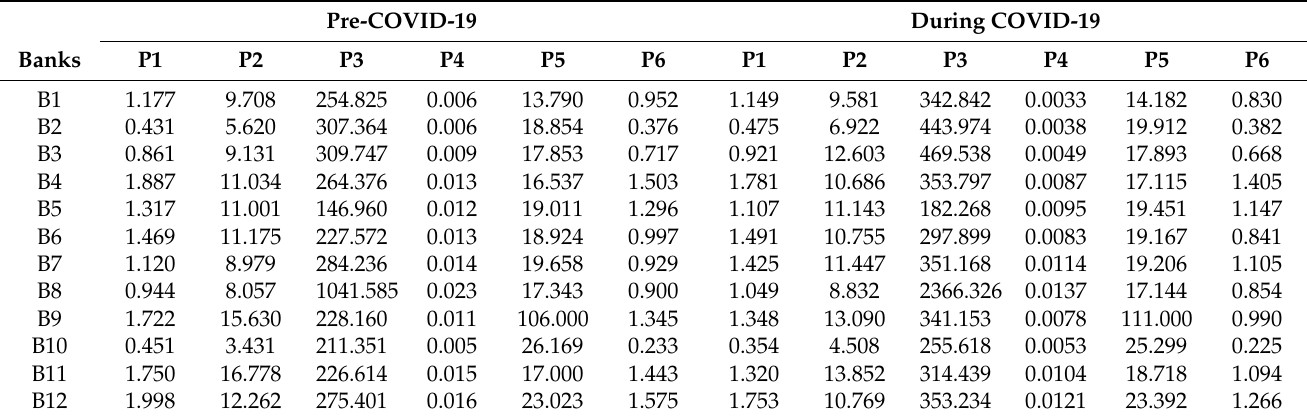
Table 5. The productivity criteria values of banks pre- and during COVID-19.